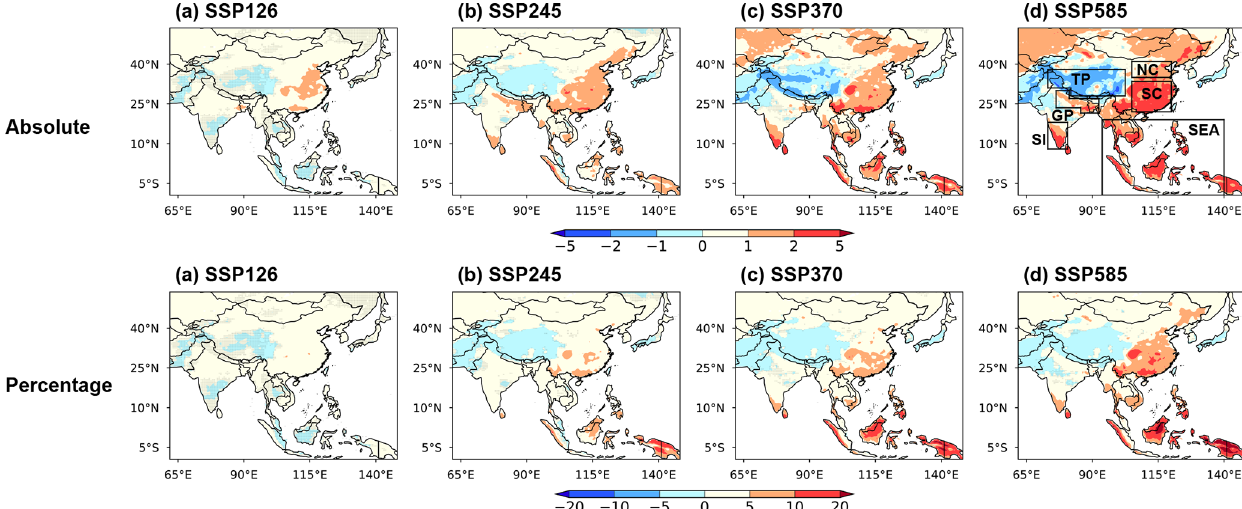
Figure 6. The spatial distributions of absolute (ppb) and percentage difference (%) of surface O 3 level between 2025 (2020–2029 mean) and 2095 (2091–2100 mean) driven by climate change under four scenarios (a, e) SSP1-2.6 (SSP126), (b, f) SSP2-4.5 (SSP245), (c, g) SSP3-7.0 (SSP370), and (d, h) SSP5-8.5 (SSP585). The box-outlined areas in (d) are North China (NC; 35–41 ◦ N, 105–120 ◦ E), South China (SC; 22–33.5 ◦ N, 105–120 ◦ E), Southeast Asia (SEA; 9 . 5 ◦ S–19 ◦ N, 93.75–140 ◦ E), South India (SI; 8–18 ◦ N, 73.125–80.625 ◦ E), the Gangetic Plains (GP; 21.5–23.5 ◦ N, 85.625–92.5 ◦ E; 23.5–27 ◦ N, 76.25–92.5 ◦ E; and 27–30 ◦ N, 76.25—81.25 ◦ E), and the Tibetan Plateau (TP; 28– 31 ◦ N, 81.875–102.5 ◦ E and 31–38 ◦ N, 73.125–102.5 ◦ E). No overlaying hatch pattern indicates statistical significance with 95% confidence from a two-tailed t